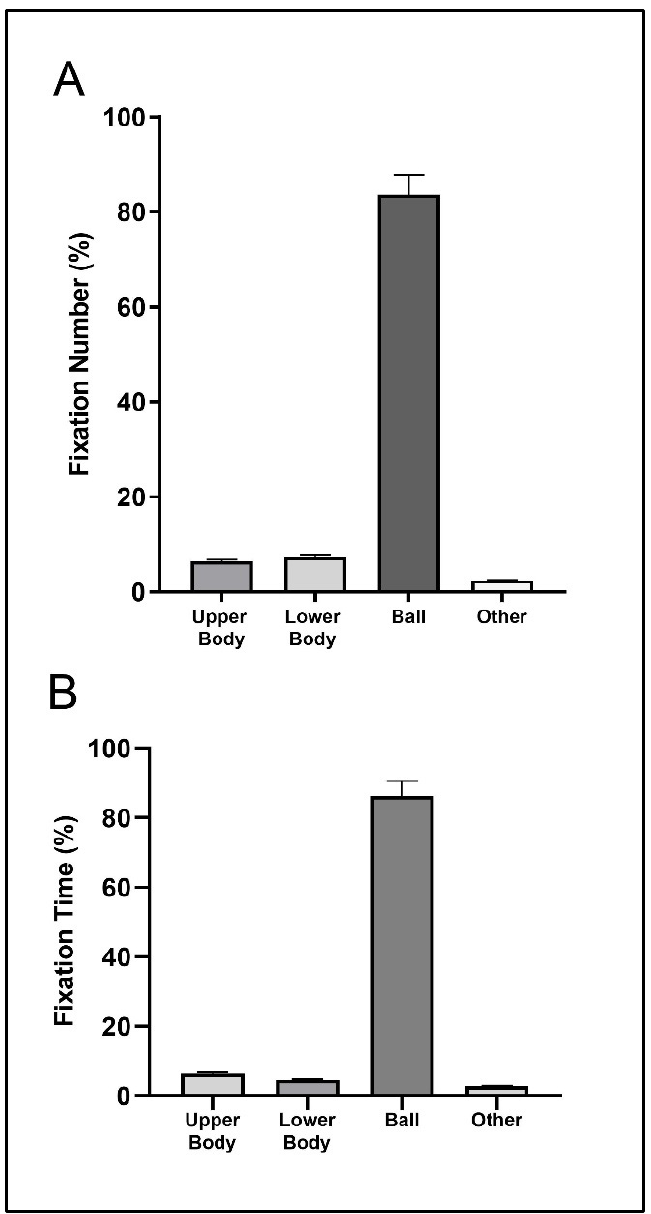
Figure 2. Mean (bar) and standard deviation (error bars with 95% confidence interval) of the relative fixation number ( A ) and fixation time ( B ) for the three return situations.